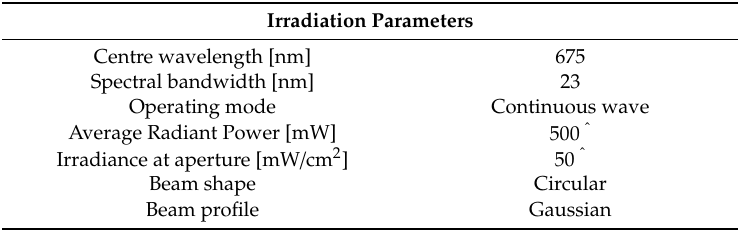
Table 2. A summary of the PBM irradiation and treatment parameters. All measurements were conducted by the researchers unless otherwise